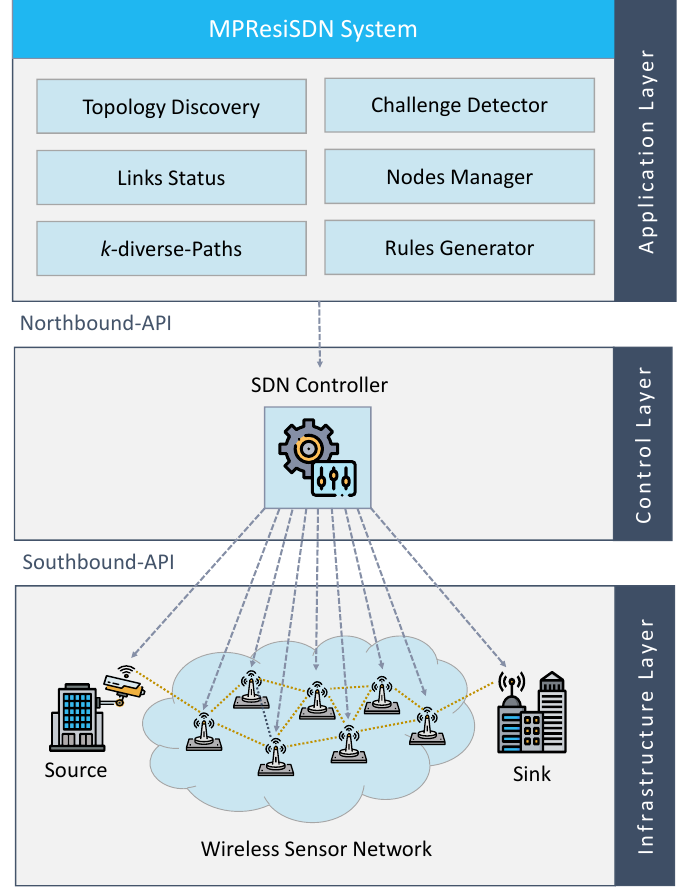
Figure 5. MPResiSDN system